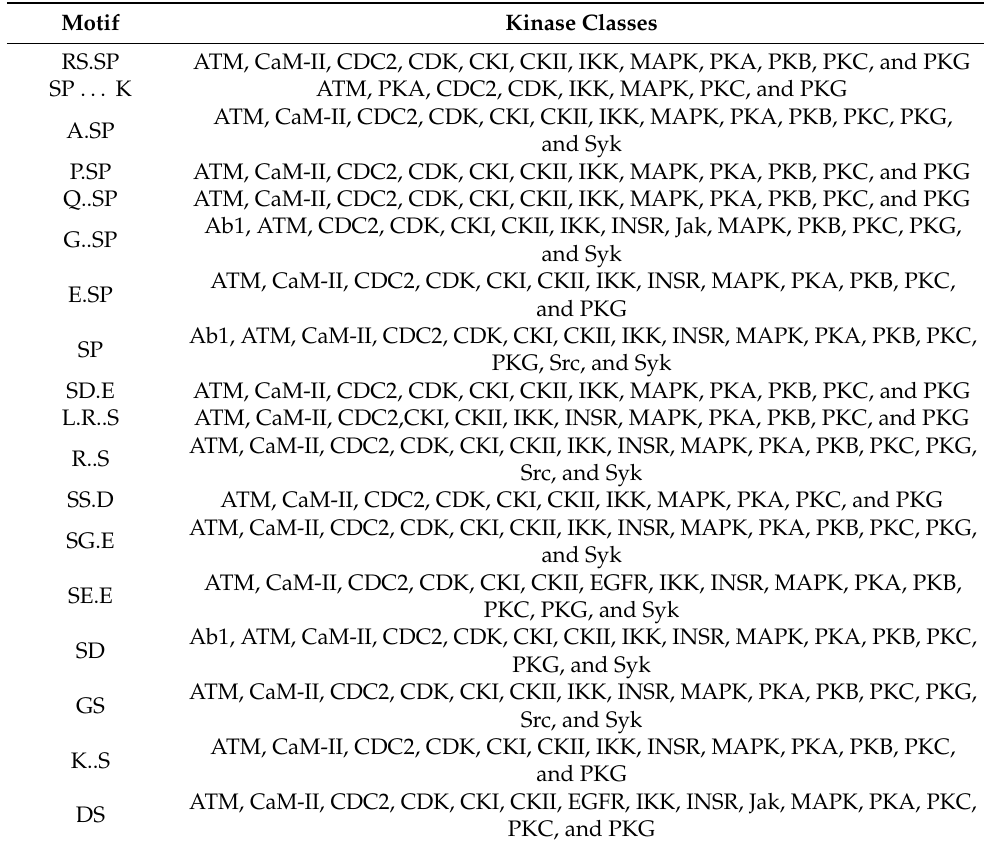
Table 2. Recording of the kinase types corresponding to the motifs of downregulated phosphorylated peptides, as identified using